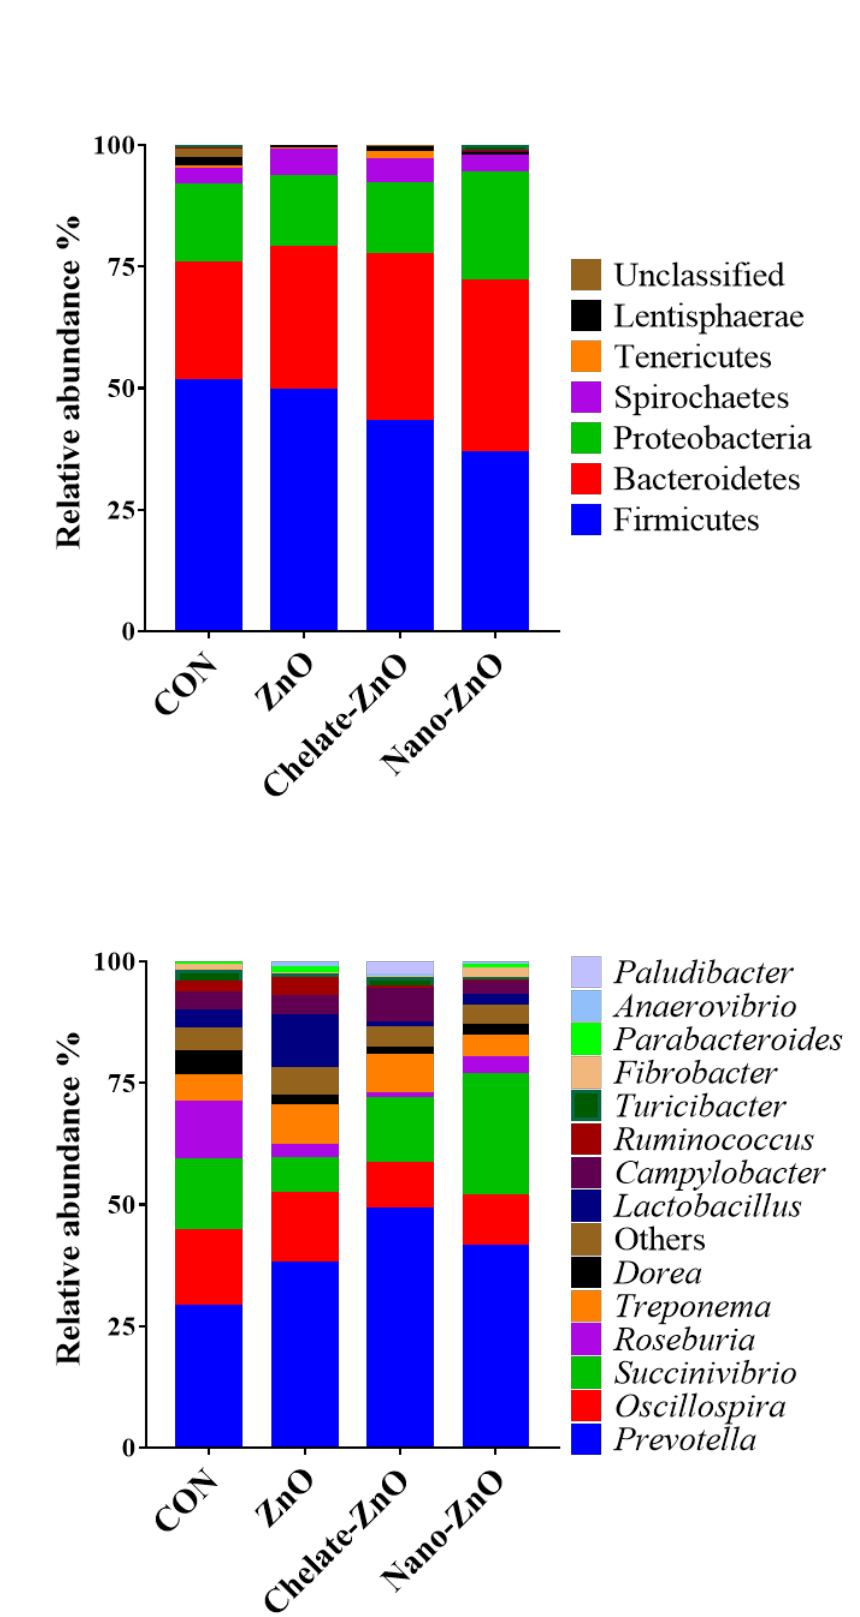
Figure 10. Taxonomic classification of the 16S rRNA gene sequences. Taxonomic analysis at the ( A ) phylum and ( B ) genus levels for the CON, ZnO, chelate-ZnO, and nano-ZnO groups were examined.